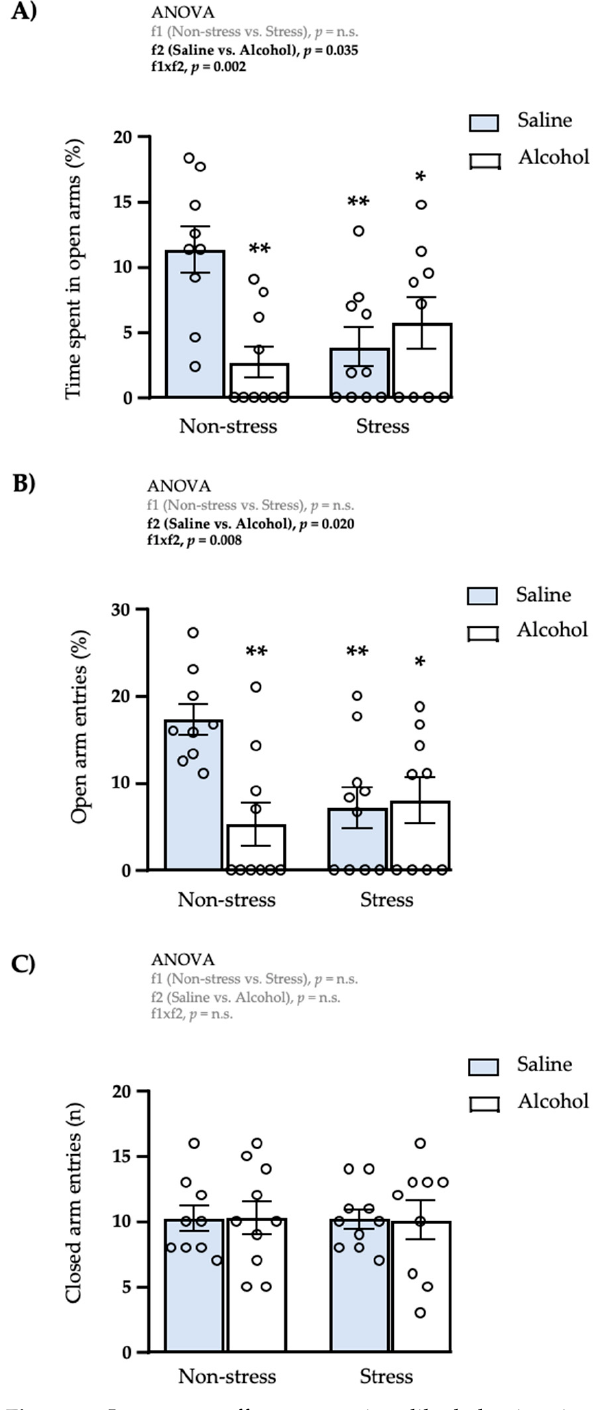
Figure 2. Long-term effects on anxiety-like behaviors in male rats exposed to repeated restraint stress and/or intermittent alcohol exposure during adolescence. Percentage of time spent in the open arms ( A ); percentage of open arm entries ( B ); and number of closed arm entries ( C ) in the EPM two weeks after the last alcohol administration. Male adult rats were exposed to repeated restraint stress (f1) and/or intermittent alcohol (f2) during adolescence. Bars represent the mean ± SEM (9–10 rats/subgroup). Data were analyzed by two-way ANOVA. (*) q < 0.05 and (**) q < 0.01 denote significant differences compared with the non-stress saline subgroup using the post hoc test for multiple comparisons when an interaction between factors is found (f1 × f2). p -values in bold denote significant main effects of factors (f1 and f2) or significant interaction (f1 × f2).